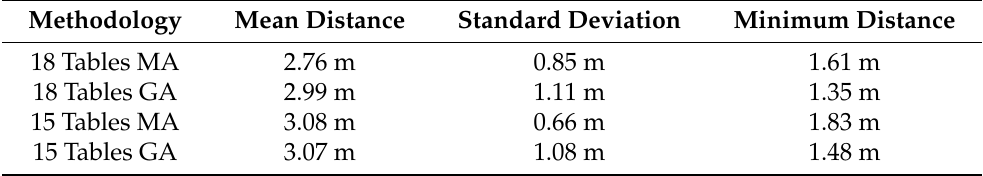
Table 4. Final metrics obtained from the MA optimisations. Results show that the MA achieved a valid distribution for all presented configurations, while the GA was unable to obtain the 1.5 m separation